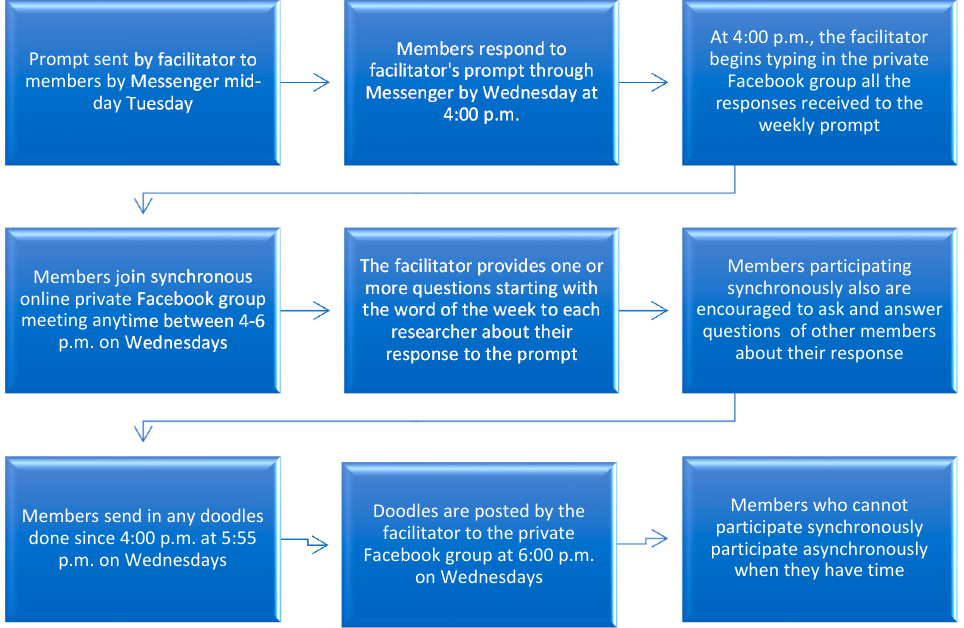
Figure 1. Weekly activities created and administered by the facilitator of the HeNReG for participants over each academic year. Weekly Activity Process Followed for HeNReG Meetings over each academic